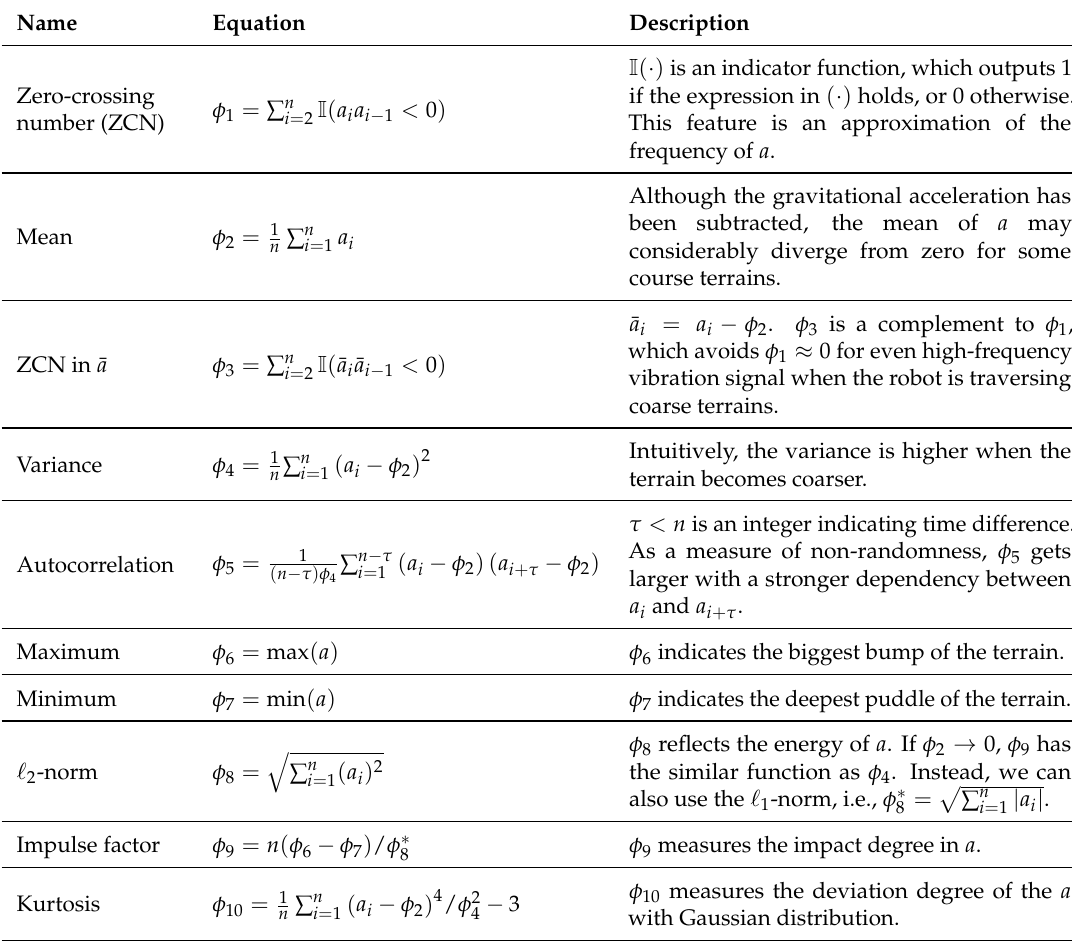
Table 1. Entries of the time-domain